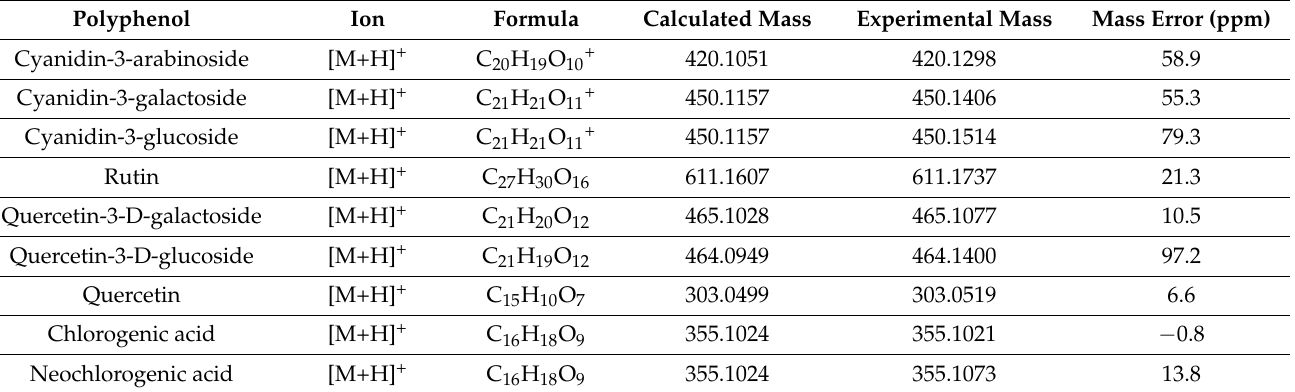
experimental mass ( m / z ), and mass error (ppm) of standards of polyphenols evaluated by DART-TOF/MS in positive mode, while Table 2 shows this data for negative mode. The DART-TOF/MS spectrum of the one sample (2% CMC) in negative mode is presented in Figure 4. Table 1. Calculated and experimental masses for evaluated standards of polyphenols obtained by DART-TOF/MS in positive